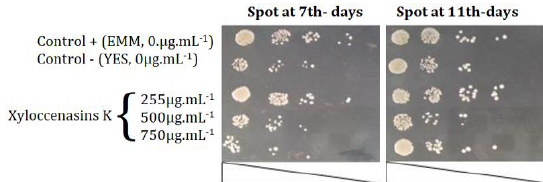
Figure 3. The effect of Xyloccensins K on the viability of S. pombe cells. Yeast was grown in YES medium supplemented with various concentrations of Xylloccensins K (25, 50, and 100 µg.mL -1 ) and incubated for 7 and 11 days. Yeast cultures of each designated incubation time were then spoted on YPD agar and incubated for three days prior to